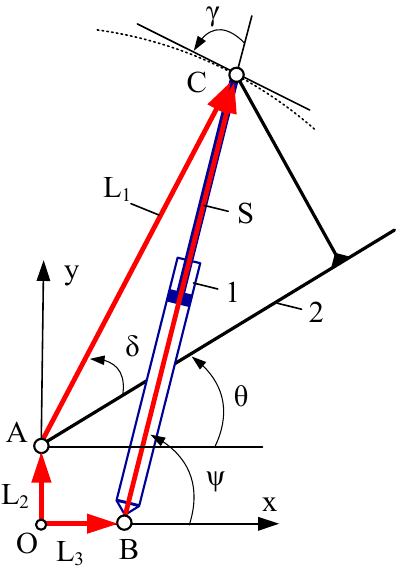
Figure 2. Schematic layout and vector closure diagram of the inverted slider-crank mechanism boom measured between the line representing the kine-